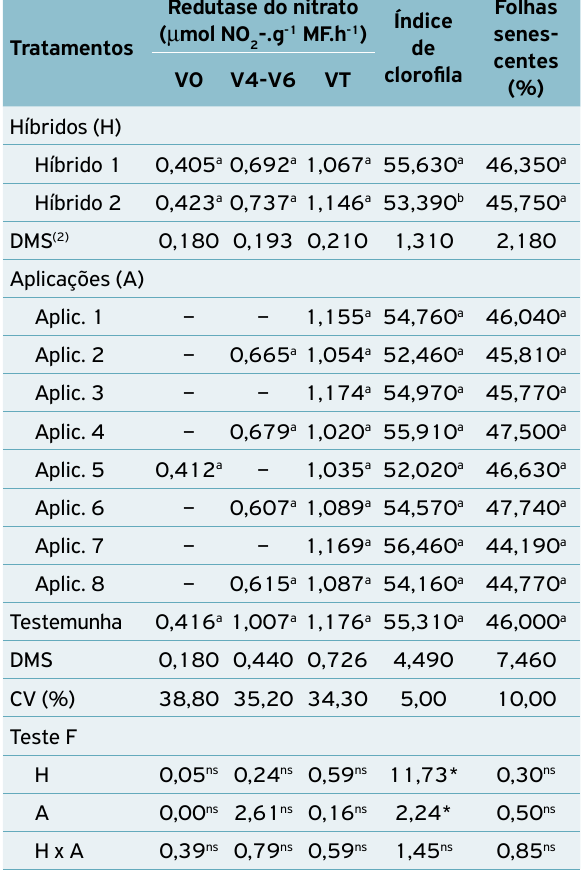
Tabela 2. Valores médios referentes à atividade da enzima redutase do nitrato nos diferentes estádios de